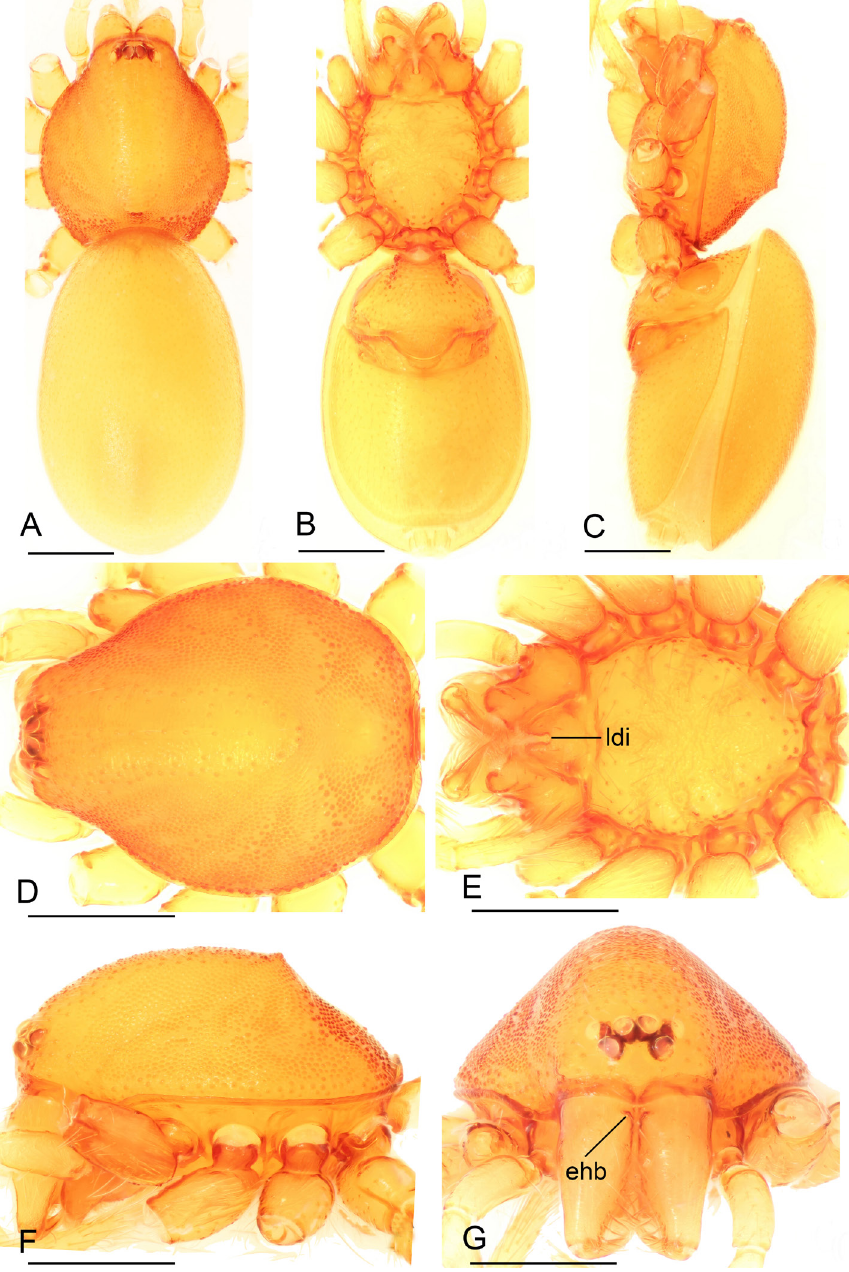
Fig. 3. Trilacuna jinyun Tong, Zhang & Li sp. nov., paratype, ♀ (SYNU-292). A – C . Habitus in dorsal, ventral, and lateral views. D – G . Prosoma in dorsal, ventral, lateral, and anterior views. Abbreviations: ehb = elevated hair base; ldi = labium deep incision. Scale bars: 0.4